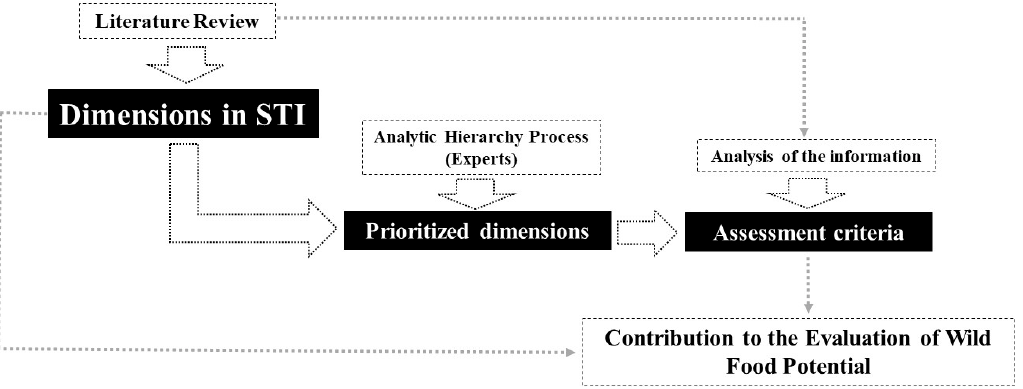
Figure 1. Methodological steps of the study.